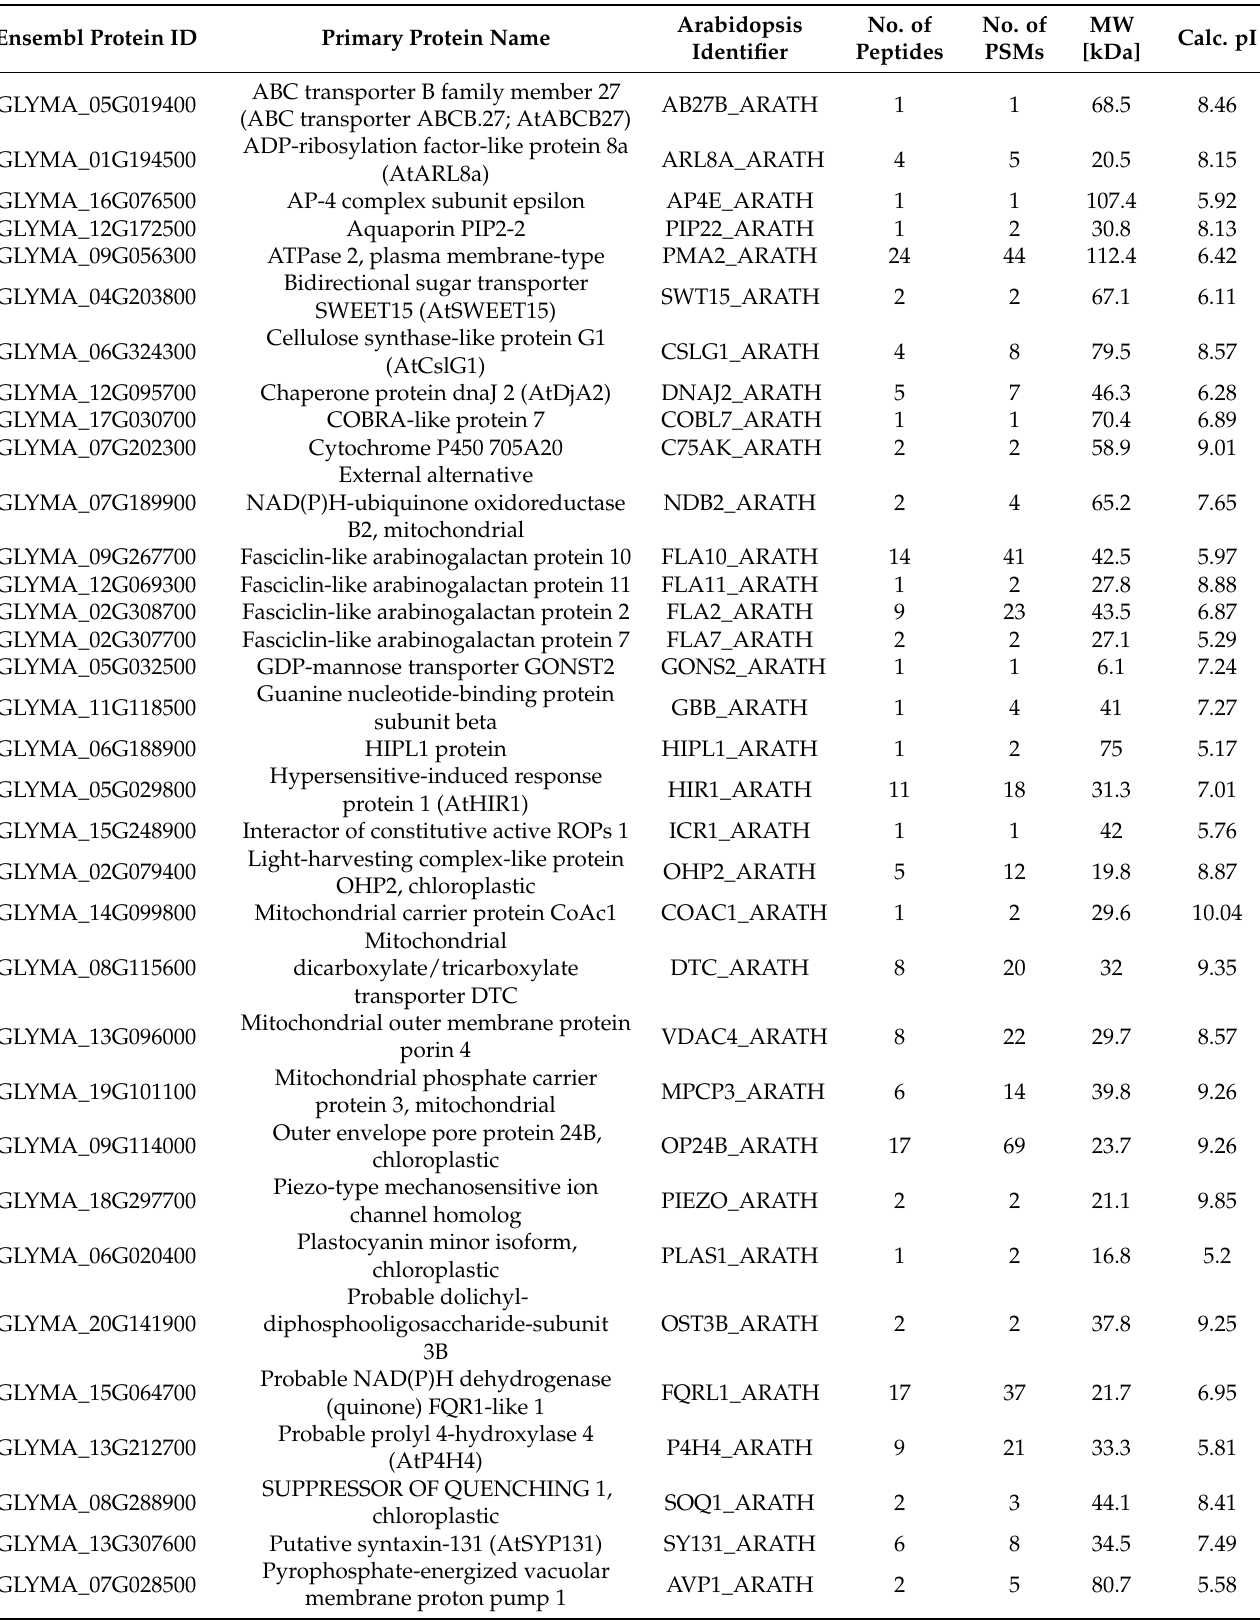
Table 5. Salt-stress-inducible membrane proteins in soybean